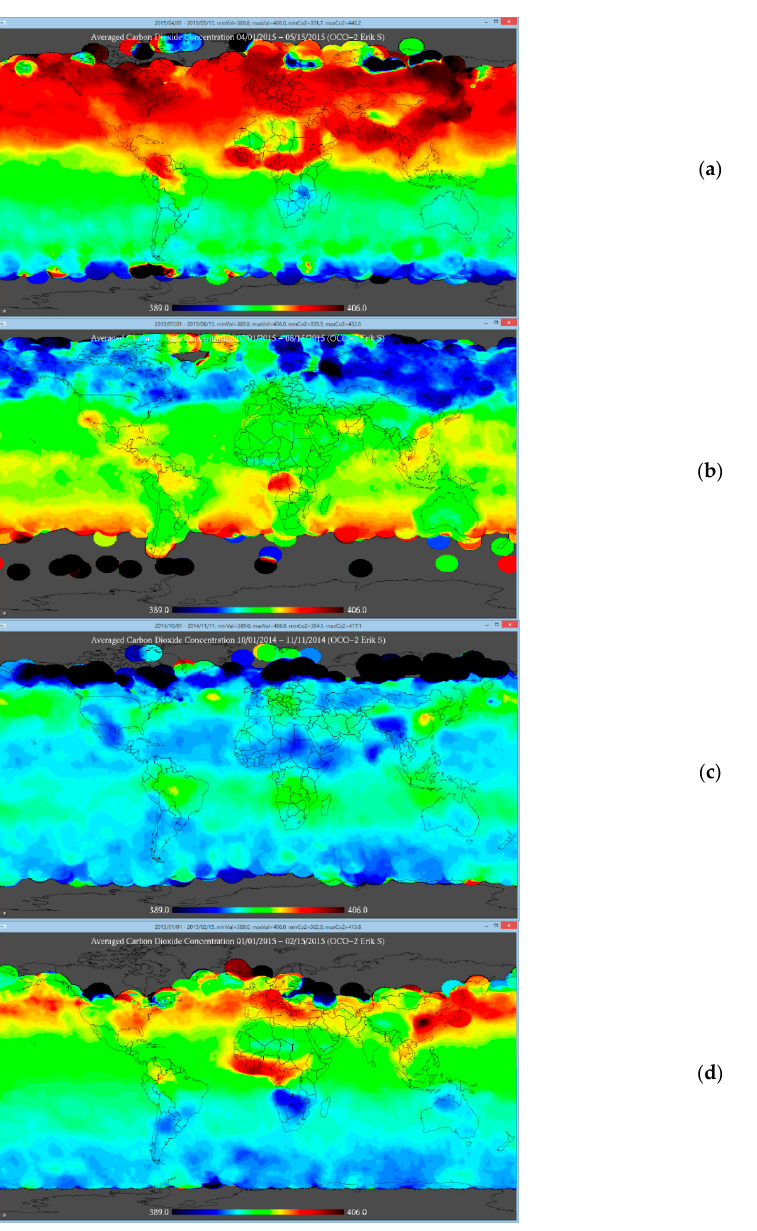
Figure 10. Atmospheric CO 2 concentration (top to bottom): ( a ) during the Northern Hemisphere springtime (1 April–15 May 2014); ( b ) summertime (1 July–15 August 2014); ( c ) autumn (1 October–11 November 2014), and ( d ) winter (1 January–15 February). Credit: NASA . After Mearns (2015 [19]). NASA copyright-free policy.